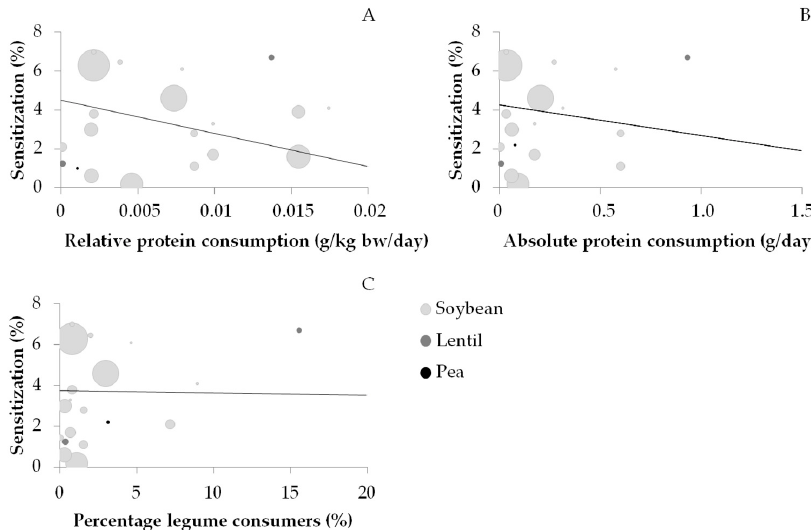
Figure 5. Sensitization data and data on relative consumption ( A ), absolute consumption ( B ), and the percentage of consumers ( C ) of soybean, lentil, and pea. The line represents the trend for soybean. Correlations between the prevalence of soybean sensitization and relative consumption ( r = 0.352), absolute consumption ( r = 0.217), and percentage of consumers ( r = 0.007) were nonsignificant ( p > 0.05).